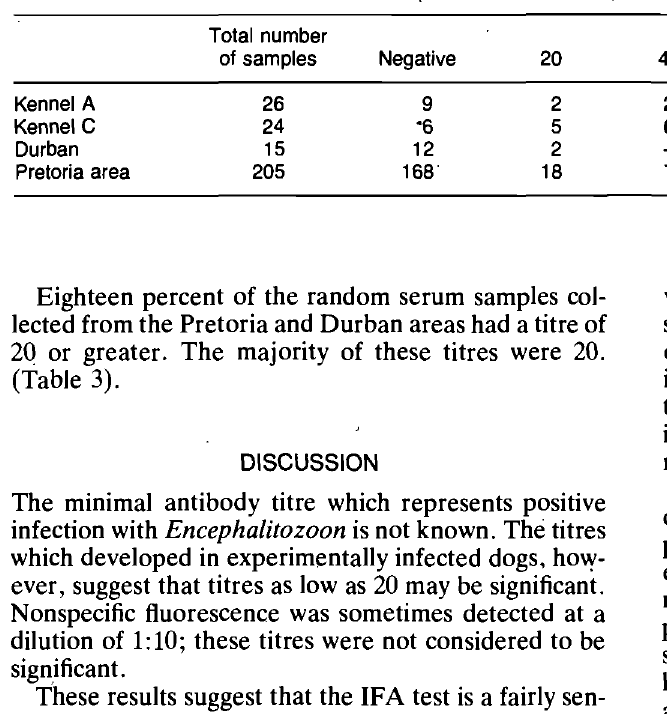
Table 3: IFA TEST TITRES FROM DOGS TAKEN AT RANDOM AND FROM OUTBREAKS OF ENCEPHALITOZOO , .